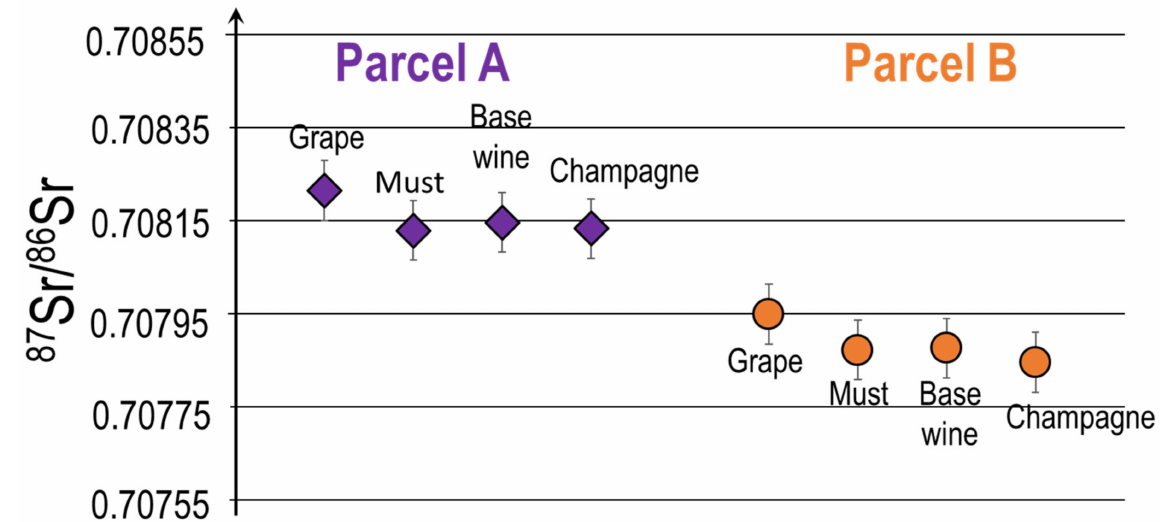
Figure 8. Evolution of Sr isotopic ratio from Grape to Champagne for two mono varietal parcels (A,B). Errors bars (2 σ ) are calculated on a triplicate of the same